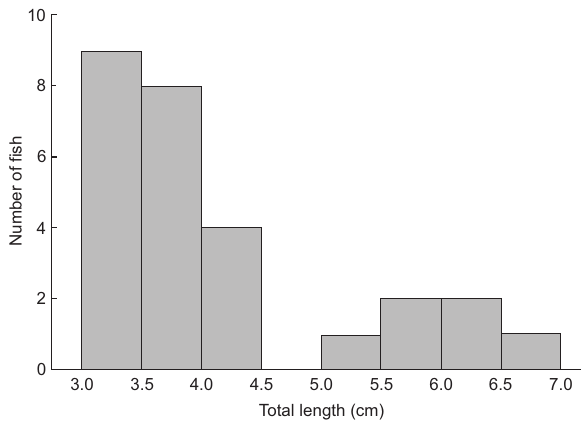
Figure 2. Number of fish per total length class tested for critical speed